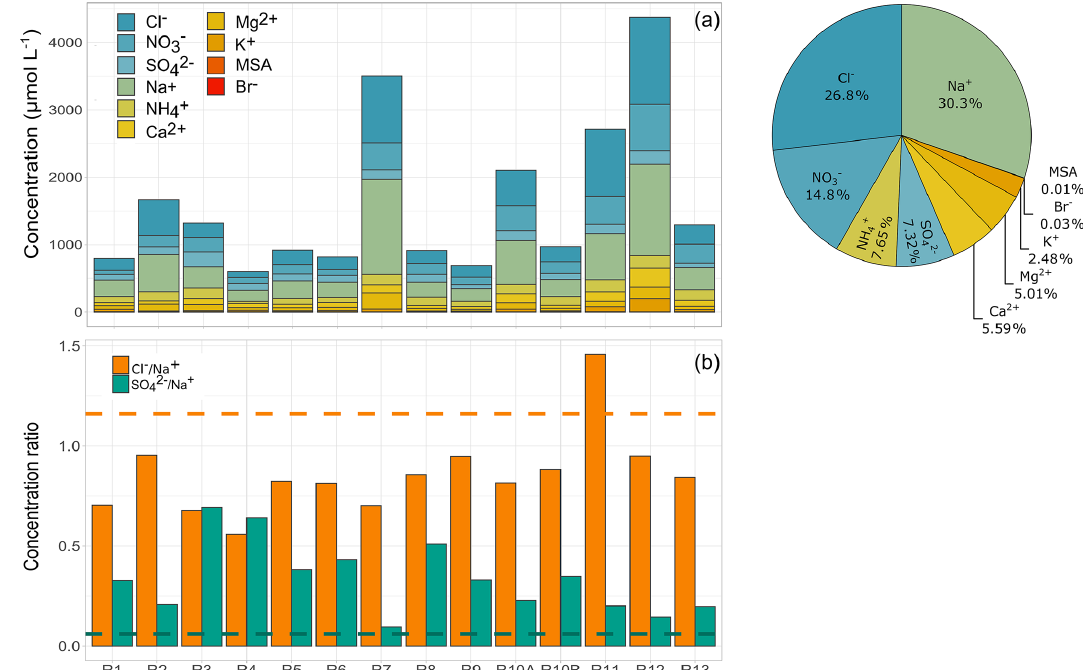
Figure 3. (a) Ion concentrations observed for each cloud event and relative contribution of each species to the total average mass. R1 to R13 refer to individual cloud samples. (b) Concentration ratios of chloride to sodium and sulfate to sodium obtained in each cloud event. Dashed lines represent the reference values of seawater content (1.17, orange line, and 0.06, green line, respectively, Holland,